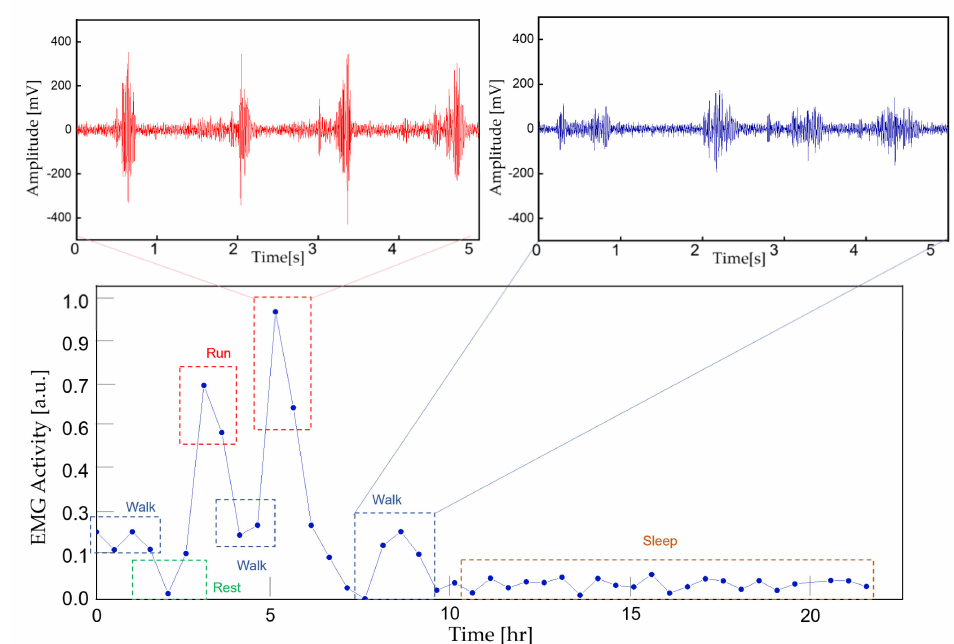
Figure 16. A continuous 30 min averaged EMG intensity for 24 h. The actual EMG signal is displayed for running and walking activity.